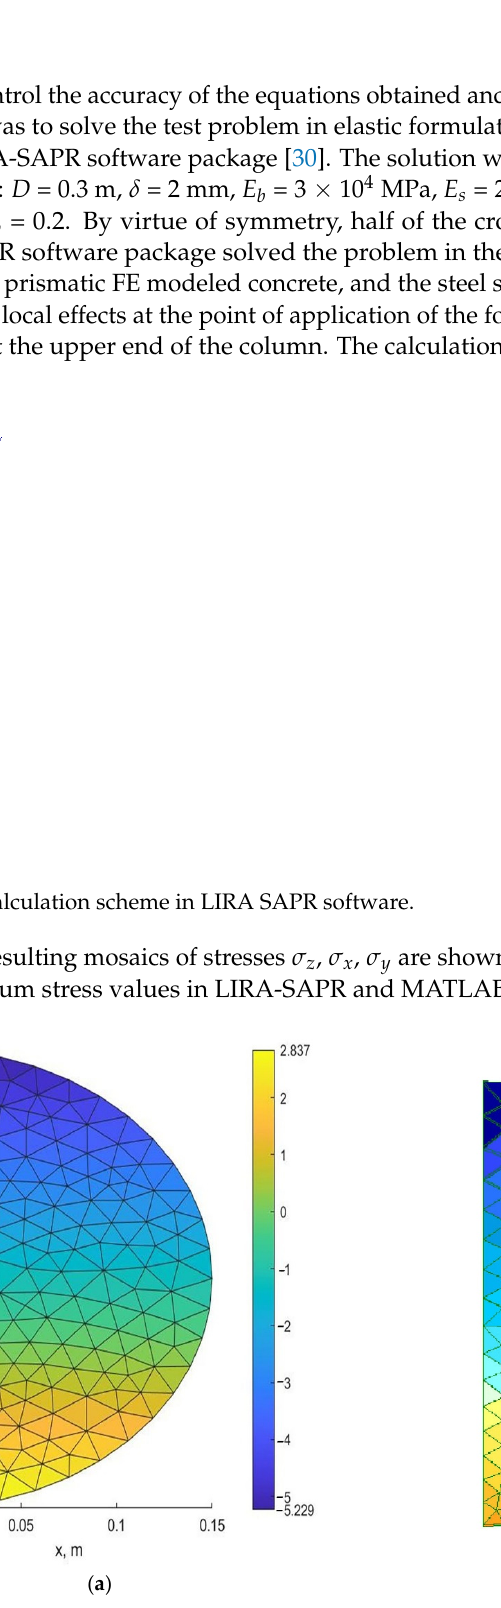
Figure 5. Mosaic of stresses σ z (MPa): ( a ) MATLAB; ( b )